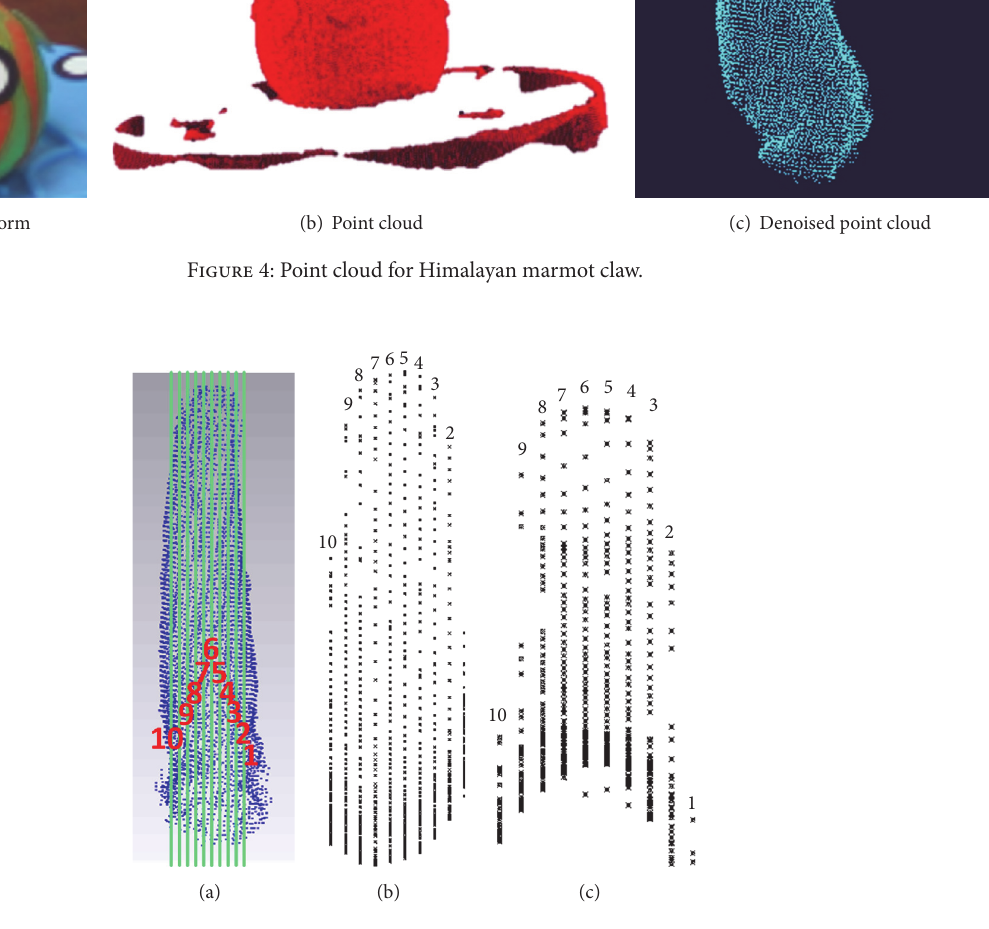
Figure 5: Data extraction based on point cloud data. (a) External contour; (b) external contour feature; and (c) obtained external contour